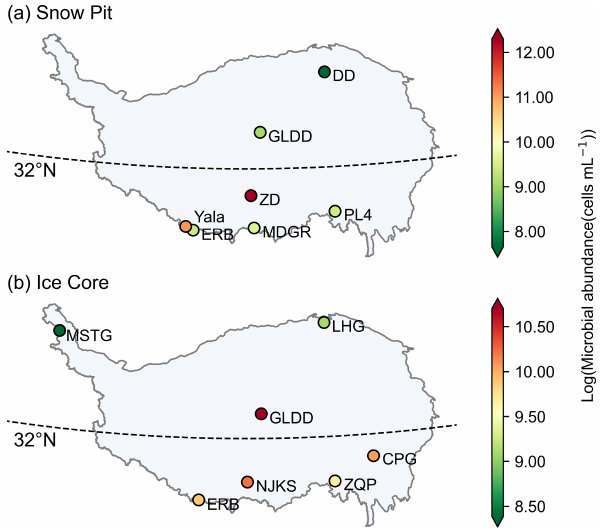
Figure 3. The spatial distribution of log(microbial abundance) for sampled snow pits (a) and ice cores (b) averaged in each